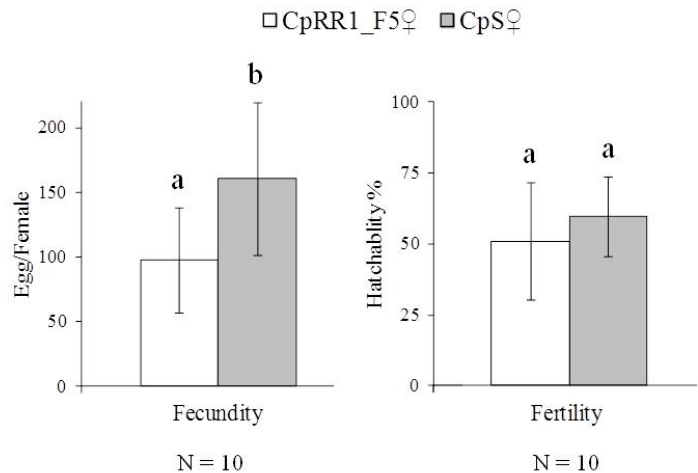
Figure 2. Fecundity and fertility of CpRR1_F5 and CpS. The eggs resulting from each (N = 10) single-pair crossings of CpRR1_F5 × CpRR1_F5 and CpS × CpS, respectively, were counted to estimate their fecundity. The fertility was assessed by the percentage of successfully hatched eggs. Error bars indicate standard deviation (SD). The different letters (a, b) on the top of the SD bar indicate statistically significant differences ( t -test, p < 0.05).